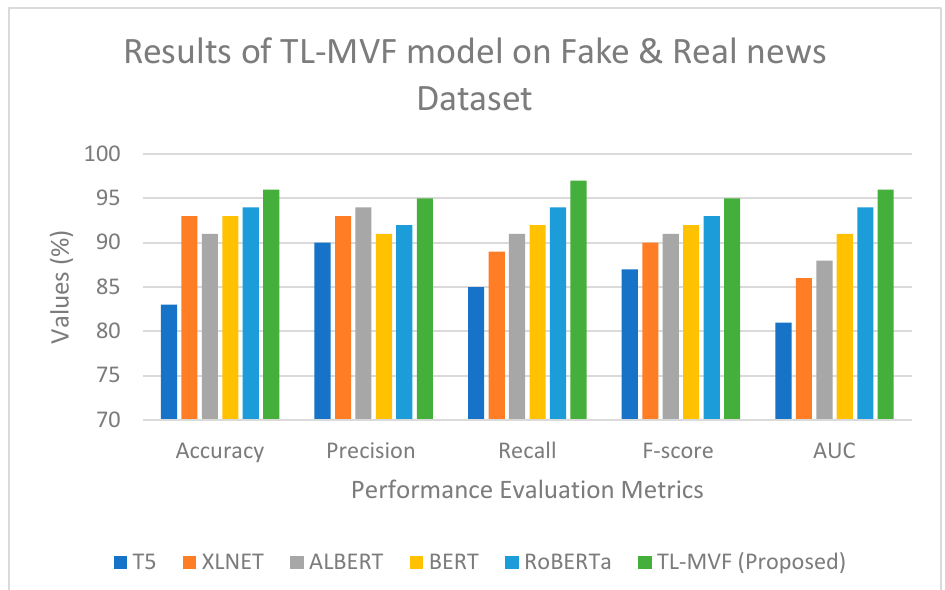
Figure 8. Comparative result analysis of TL-MVF with existing benchmarked models over the Fake and Real News dataset.